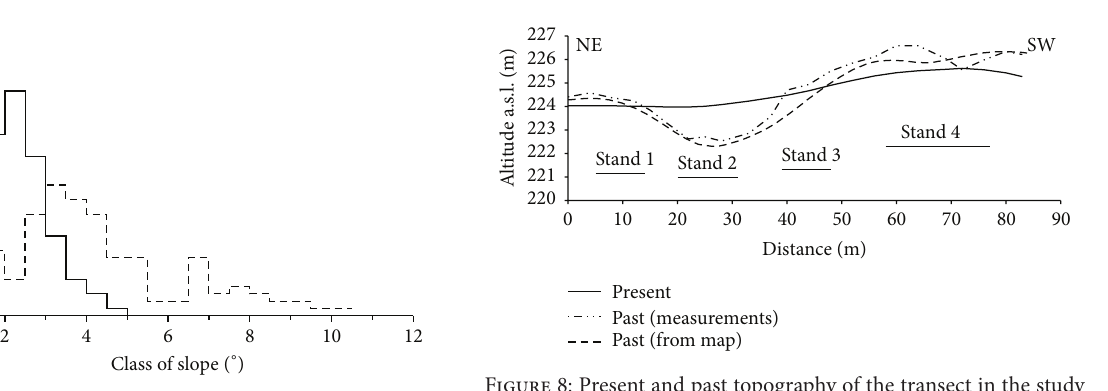
Figure 8: Present and past topography of the transect in the study area with localization of four soil